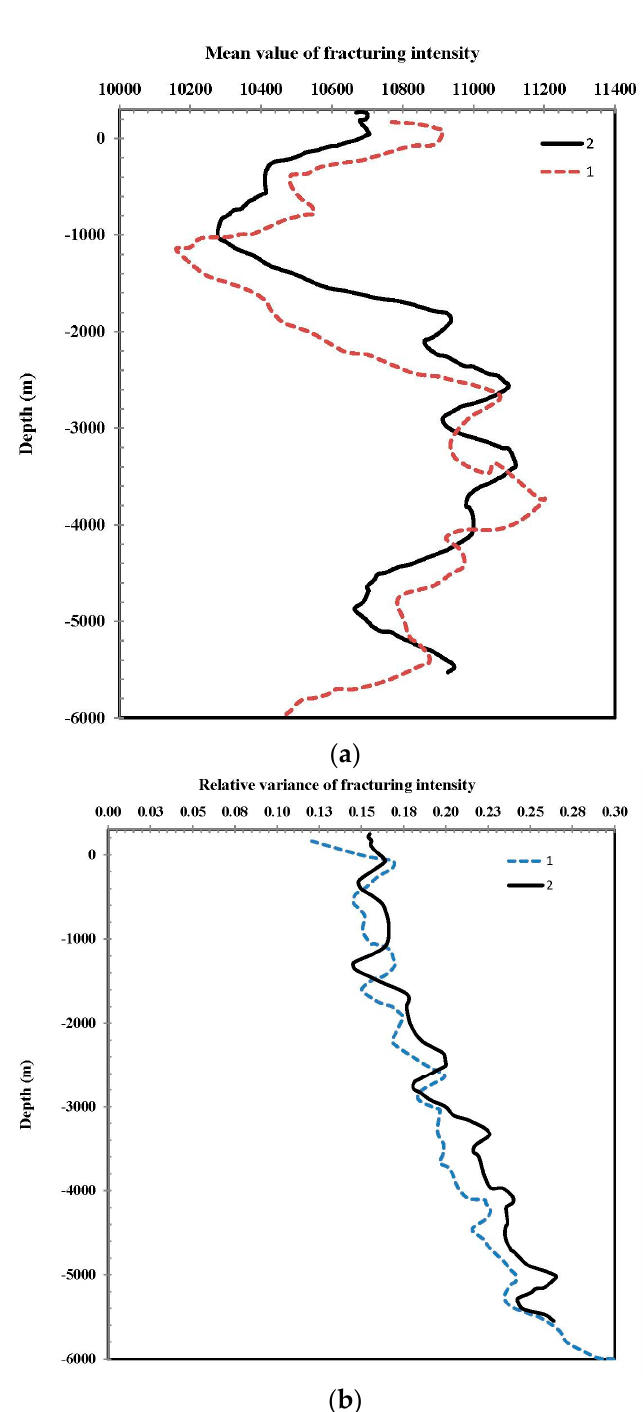
Figure 8. Variation of the mean value ( a ) and relative variance ( b ) of fracturing intensity within horizontal (1) and lateral slices (2) in the study